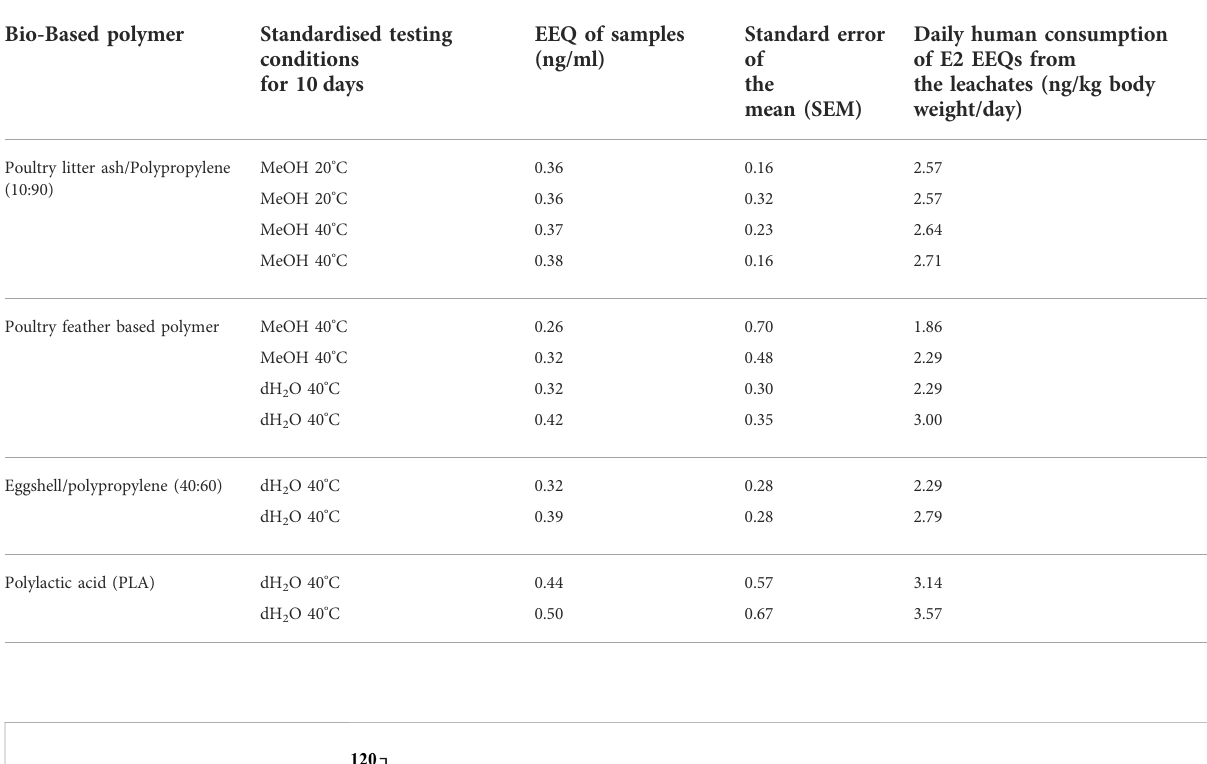
TABLE 5 The E2 equivalent estrogenic quantity (EEQ) calculated using the MMV-Luc (estrogen responsive) cell line as a measure of the estrogenic activity which leached from the bio-based polymers poultry litter ash/polypropylene (10:90), poultry feather based polymer, eggshell/ polypropylene (40:60) and polylactic acid (PLA) and estimated daily human consumption of E2 EEQ via food packaging exposure. Bio-Based